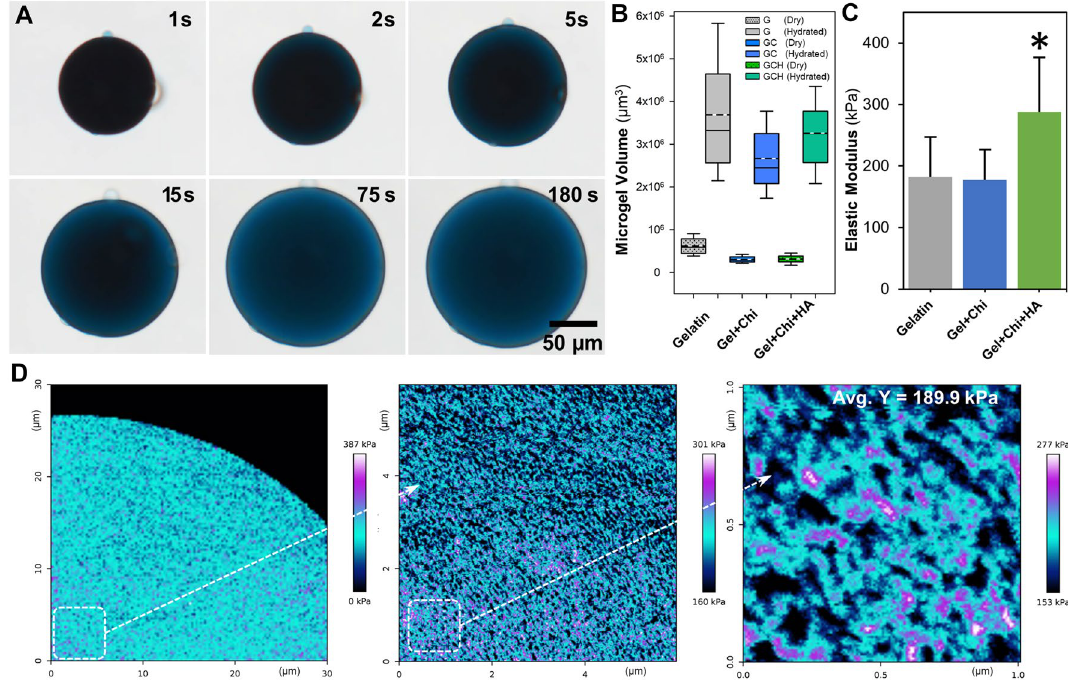
Figure 2. Microgel swelling and elasticity. ( A ) Temporal bright-field images of a microgel being hydrated in PBS. ( B ) The change in volume of the microgels at the equilibrium hydration condition (n > 100, G = Gelatin, GC = Gelatin + Chitosan, GCH = Gelatin + Chitosan + HA). ( C ) The compressive modulus of the gelatin hydrogels changed slightly depending on the formulation (n = 10). ( D ) Young’s modulus map of a hydrated gelatin microgel at different magnifications. Micrographs were obtained using an AFM in QI mode. Young’s moduli map was constructed using a Hertzian model fit on the ‘extend’ curve with a parabolic profile for the tip